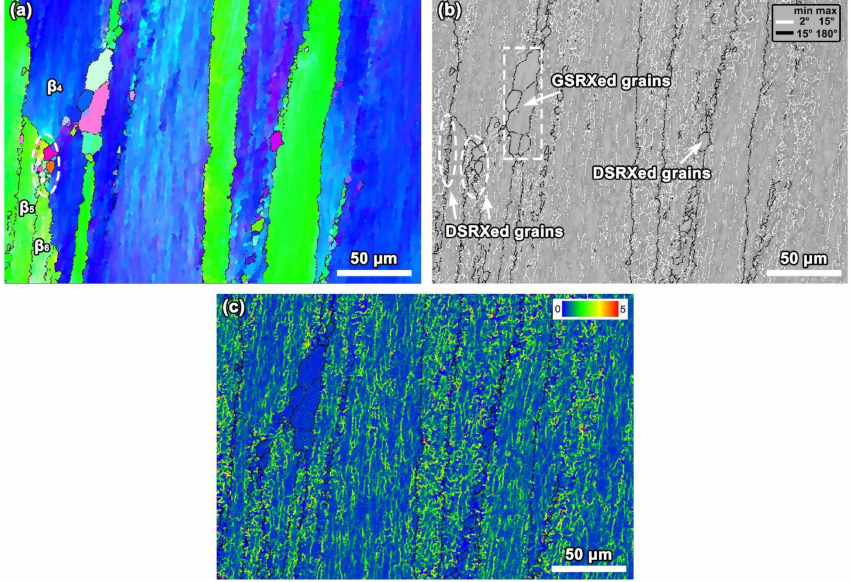
Figure 5. Analysis of discontinuous static recrystallization mechanism of specimen HT-1: ( a ) IPF map; ( b ) grain boundaries misorientation; ( c ) KAM